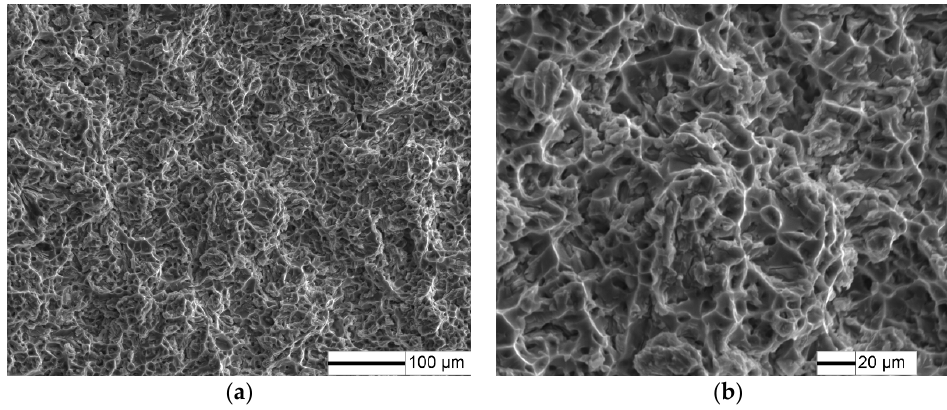
Figure 13. Tensile fracture graph (SEM) with optimum parameters: ( a ) ×200; ( b ) ×500.